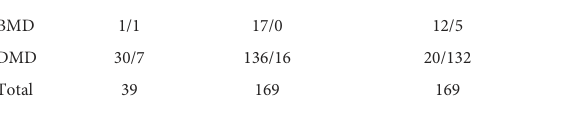
TABLE 2 The genotype of 169